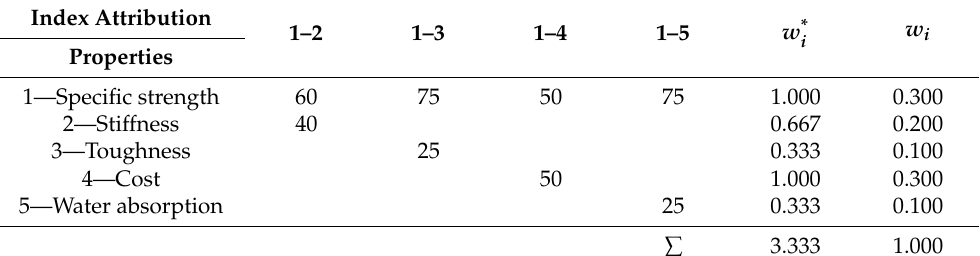
Table 4. Properties index weight attribution for the box and pillar.